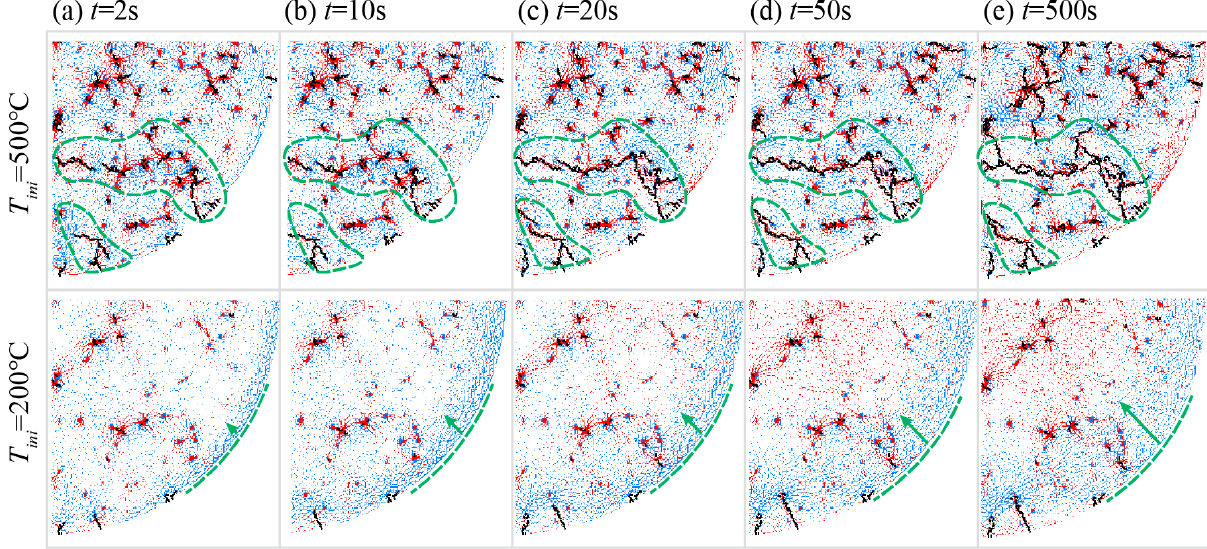
Figure 12. Evolution of thermal stress field and thermal cracks. Note: the red and blue solid lines represent the contact between particles in compression and tension, respectively, and their thickness represents the relative magnitude of the force.